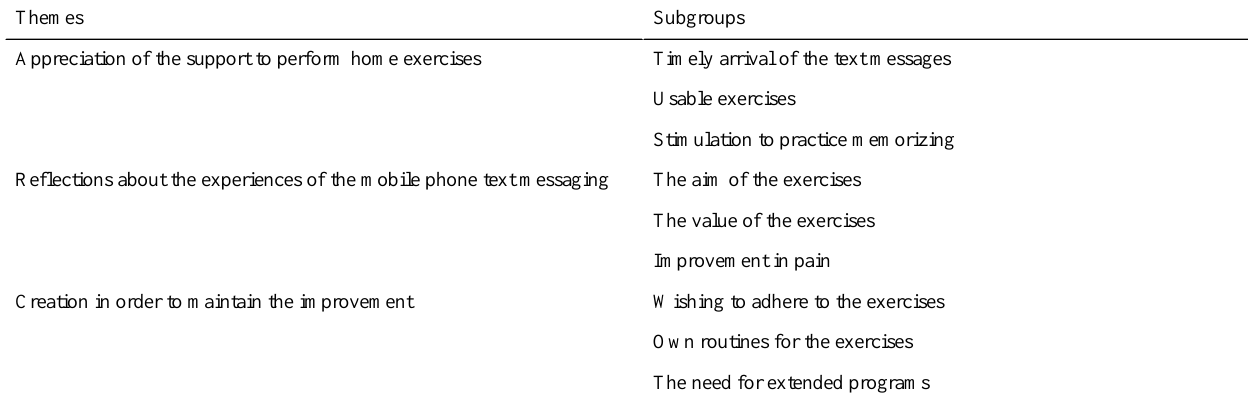
Table 2. Data analysis.